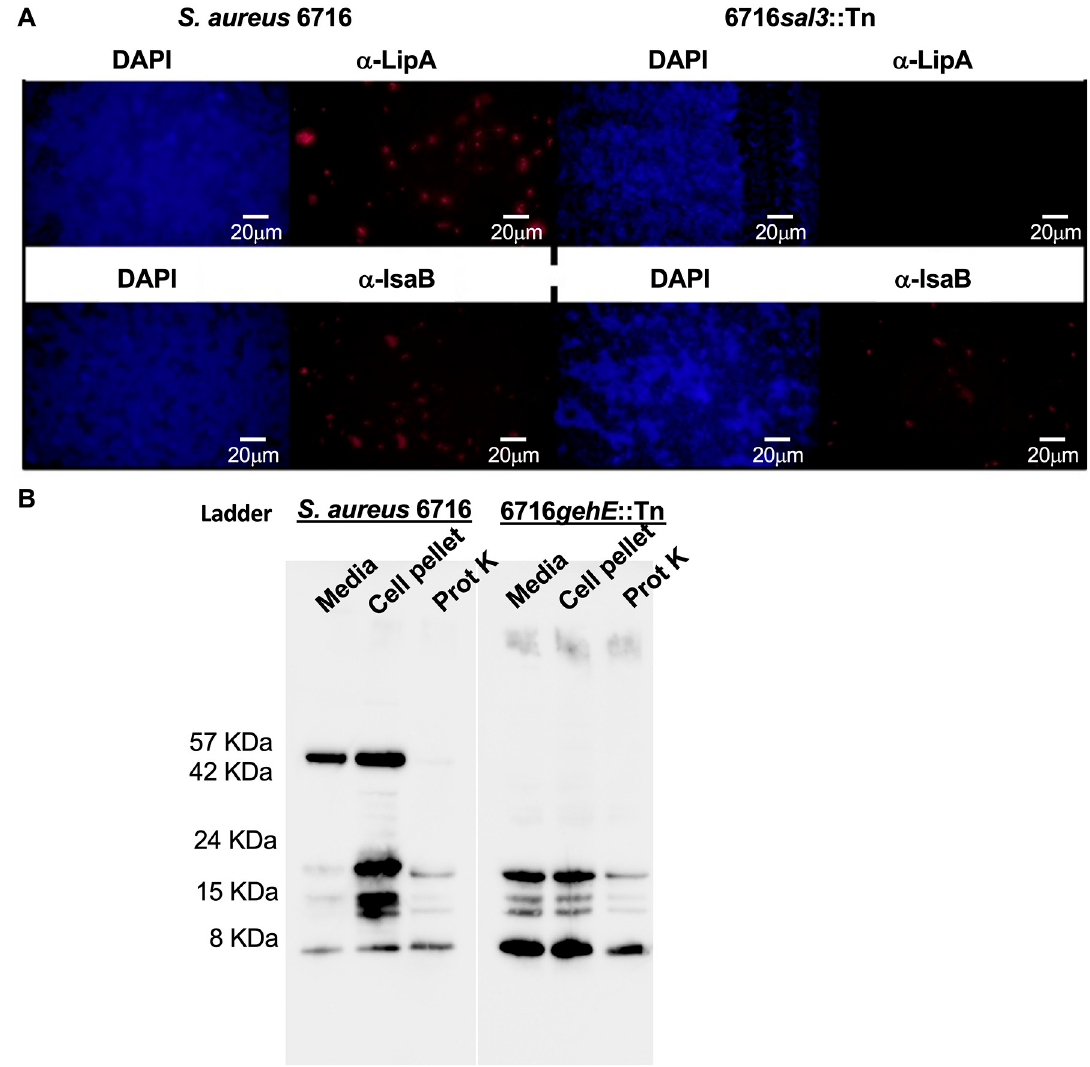
Fig 2. SAL3 is extracellular and associated with the cell envelope. A. Localization of SAL3 in wild type S . aureus strain 6716 (protein A deficient) and mutant 6716 gehE ::Tn was determined using primary polyclonal rabbit antisera raised against recombinant protein and detection by immunofluorescence using an Alexa Fluor 594-conjugated secondary antibody. IsaB antisera was used as a positive control for a surface-associated protein. DAPI was used to stain DNA inside the bacteria. B. Western blot of SAL3. From left to right: Media: Spent medium from culture of protein A-deficient S. aureus strain 6167. Cell pellet: 6167 cells lysed directly in denaturing PAGE buffer. Prot K: 6167 cells treated with proteinase K (shaved). Media: Spent medium from 6716 gehE ::Tn culture Cell pellet: 6716 gehE ::Tn cells Prot K: 6716 gehE ::Tn treated with proteinase